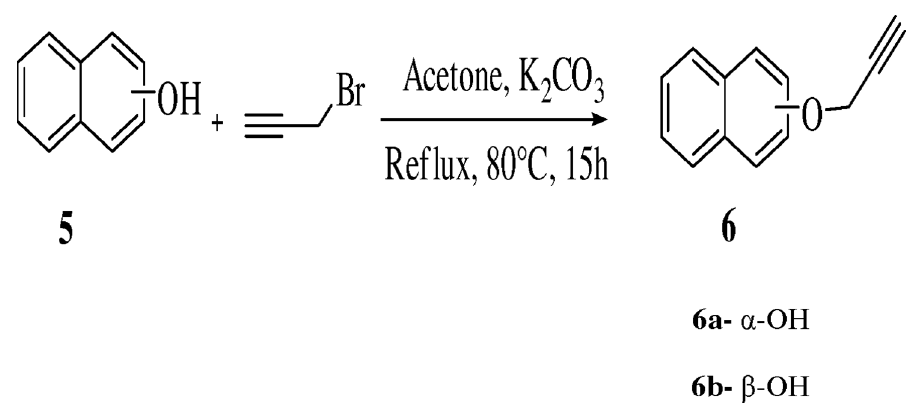
Fig. 3. Synthesis of compounds 6a–b.